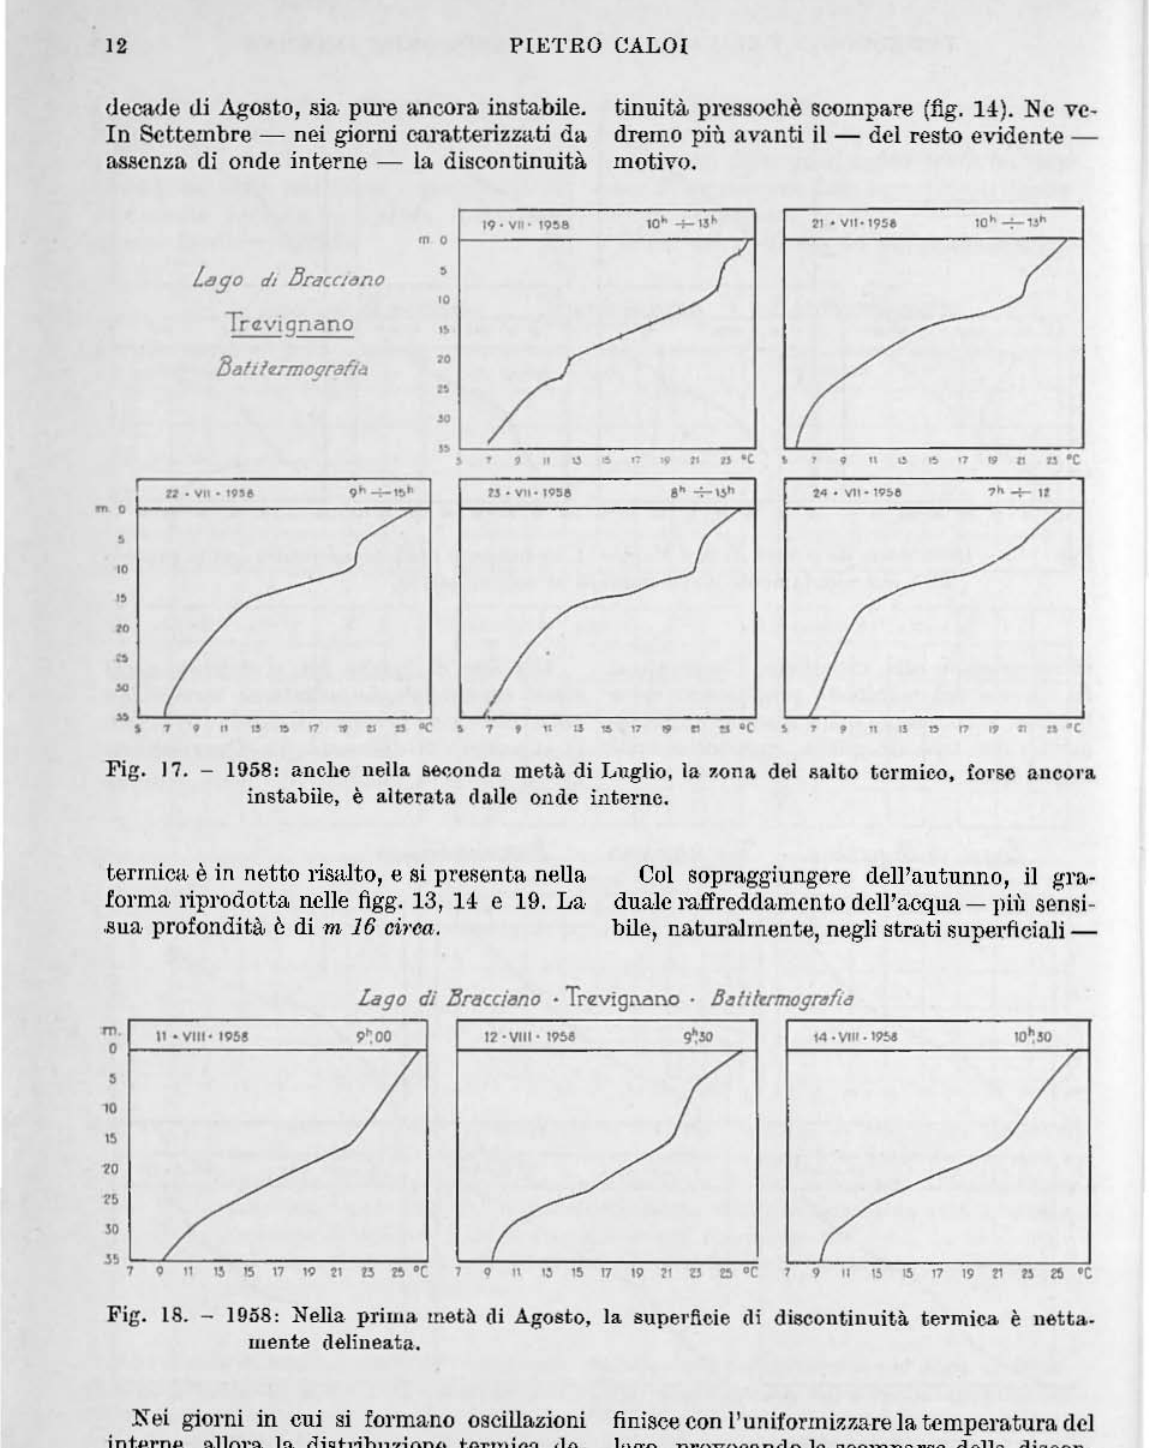
Fig. 18. - 1938: Nella. prillia. metà di Agosto. la. supel·tleie di discontinuità termica. è netta. mente